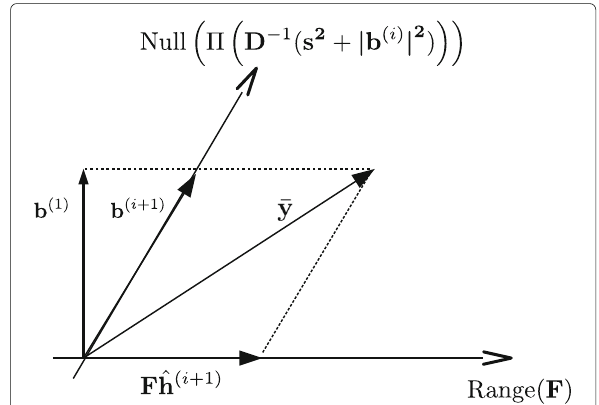
Fig. 2 Iteration i ≥ 1 of the CML algorithm: oblique projection